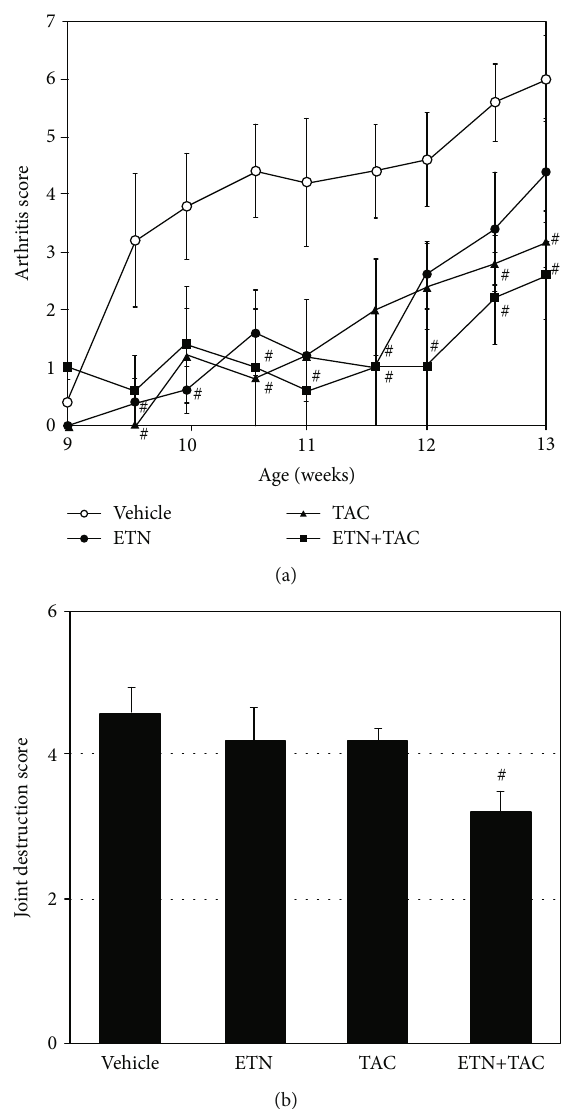
Figure 1: Tacrolimus and its combined treatment with etanercept attenuate the progression of arthritis in hTNF-Tg mice. Etanercept (ETN; 4mg/kg) was administered subcutaneously twice a week for 4 weeks, and tacrolimus (TAC; 3 mg/kg) was administered orally once daily for 4 weeks. (a) Results are shown as the arthritis score and the mean ± standard errorof the mean (SEM) of fi ve animals per group. (b) Arthritis- associated radiographic changes were evaluated in a blinded manner at the end of the treatment period. The joint destruction score and the mean ± SEM of fi ve animals per group are shown. Data are representative of two independent experiments. # p < 0 : 05 compared with the vehicle-treated mice (Dunnet ’ s multiple comparison